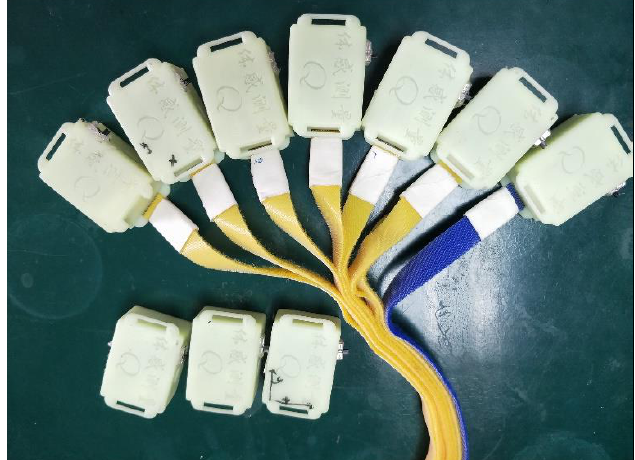
Figure 2. Hang3.0 inertial sensors schematic diagram.